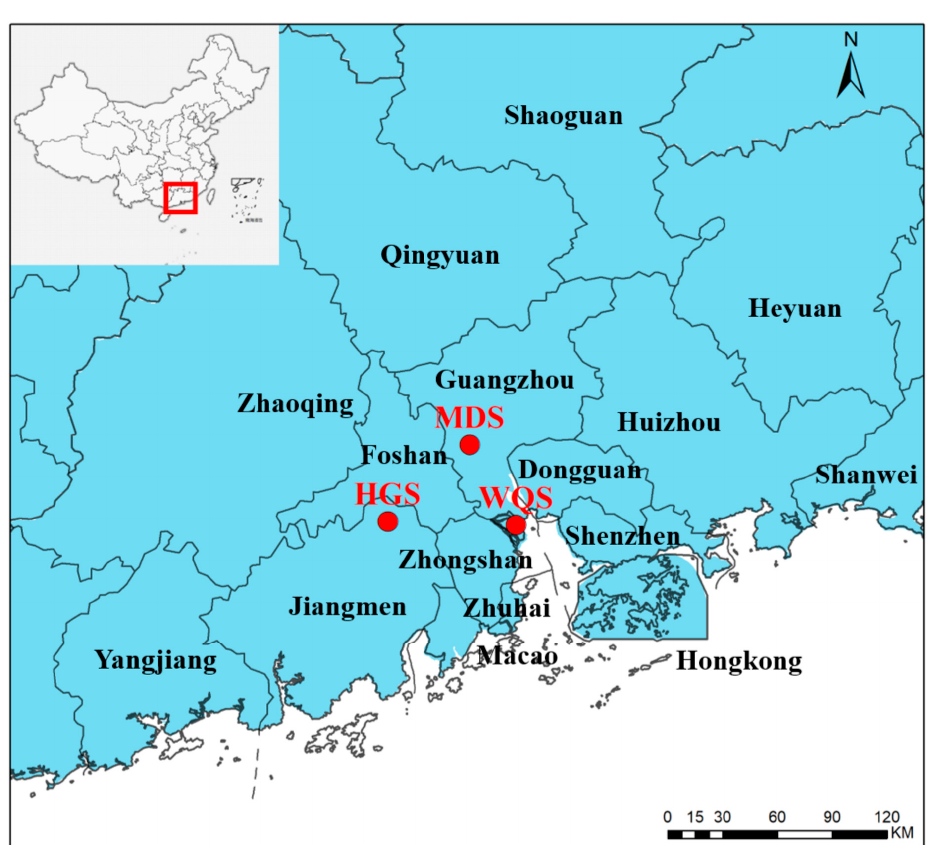
Figure 1. Location of the three monitoring sites in the Pearl River Delta.